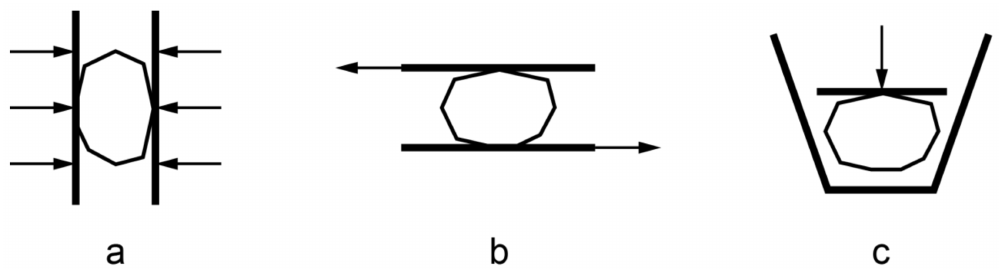
Figure 1. Modes of size reduction: a—two-sided compression, b—shearing, c—one-sided